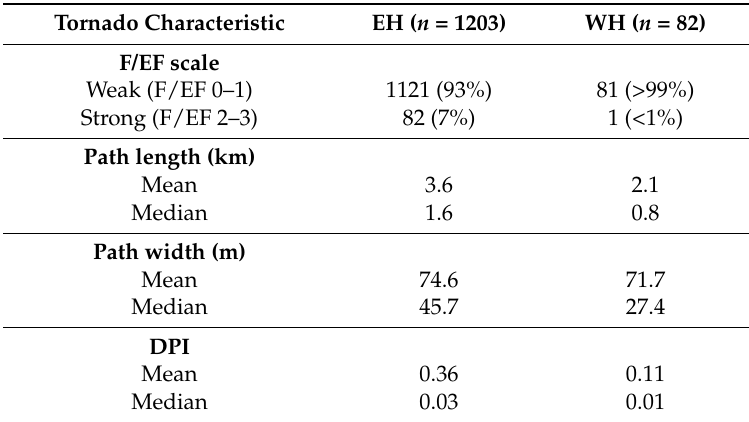
Table 11. Descriptive statistics for the east and west halves (EH and WH, respectively).